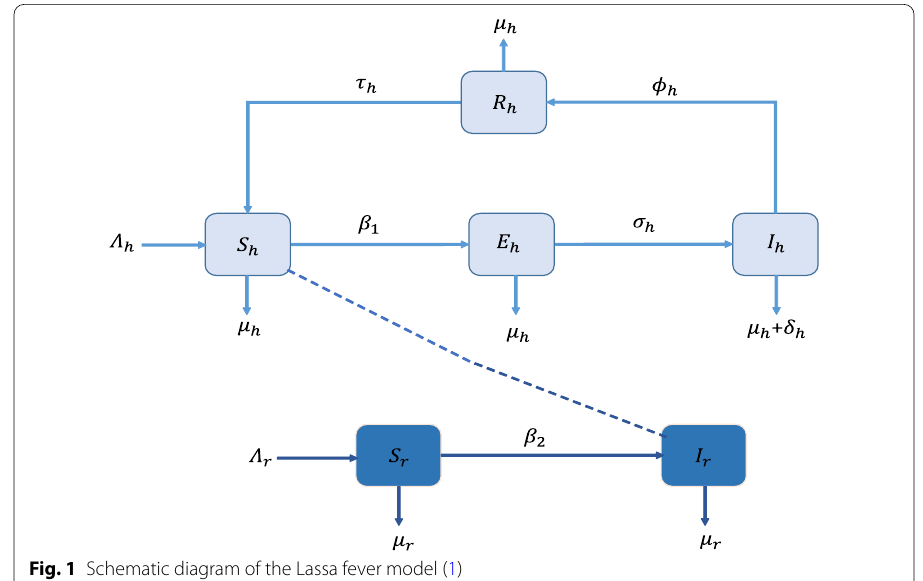
Fig. 1 Schematic diagram of the Lassa fever model (cid:31) r . This subpopulation is reduced by infection following effective contact with infected